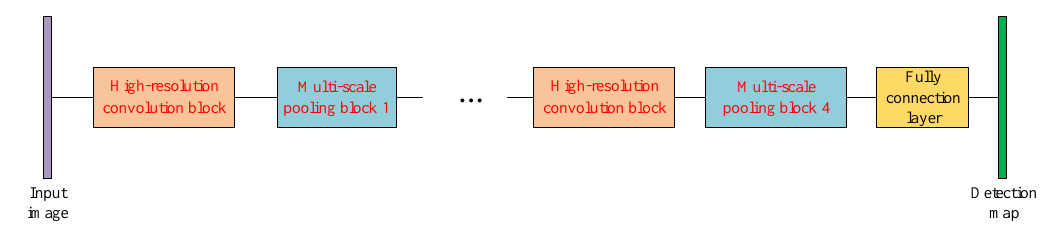
Figure 10. The structure of the proposed sub-network for nodule